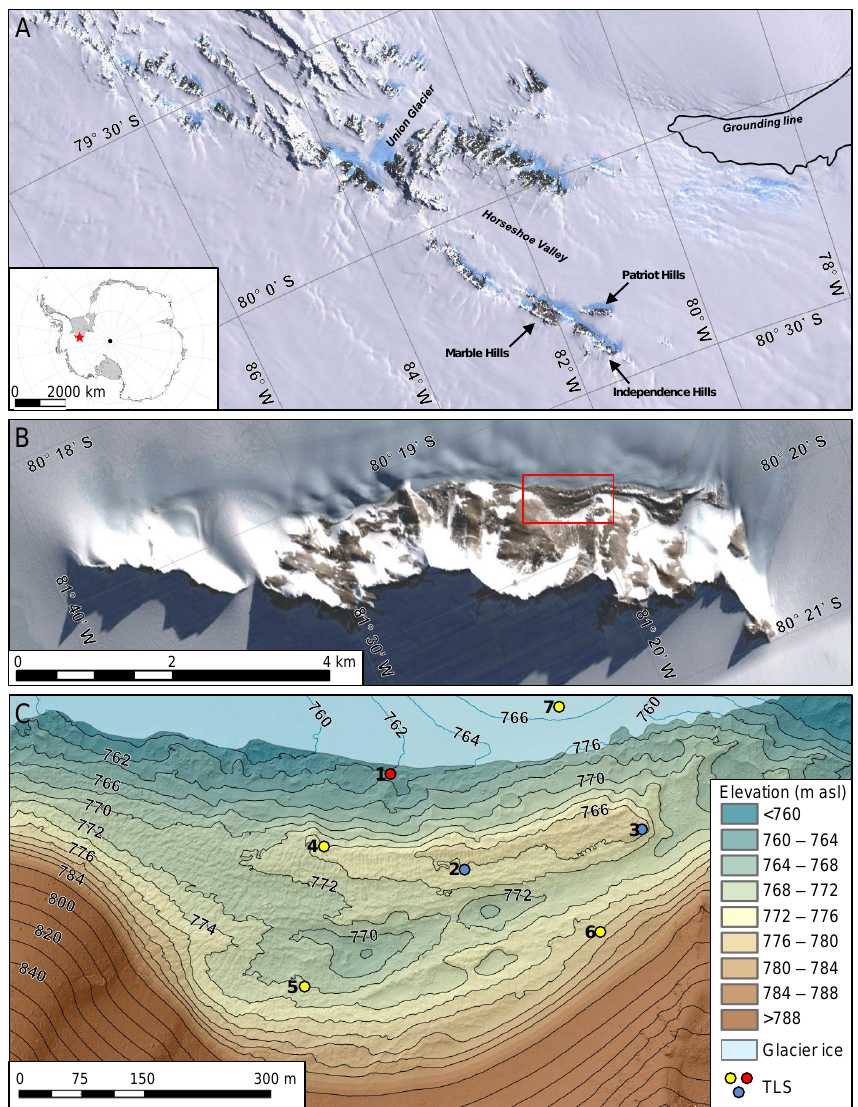
Figure 1. Blue-ice moraine embayment, Patriot Hills, Heritage Range, Antarctica. (a) Geographical context of Patriot Hills within the Heritage Range, southern Ellsworth Mountains. (b) The Patriot Hills massif. The location of the study embayment and area displayed in (c) is highlighted in red. (c) Detailed study site overview map. Contours and underlying hillshade are derived from a UAV-SfM-derived digital elevation model (DEM). TLS positions for the start of season 1 are shown in red, blue and yellow. The two scan positions reoccupied at the end of season 1 are shown in blue, whilst the three scan positions reoccupied in season 2 are shown in blue and red. Background to (a) © U.S. Geological Survey; background (b) © 2015 DigitalGlobe; both extracted from Google